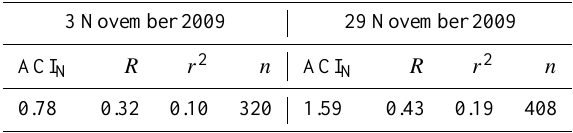
Table 3. ACI N (Eq. 7) and the statistical parameters calculated be- tween ln (N d ) and ln ( ATB ) , namely the Pearson product-moment correlation coefficient, R , and the coefficient of determination, r 2 , and the number of observations, n , for two case studies from Gra- ciosa Island, the Azores (3 and 29 November